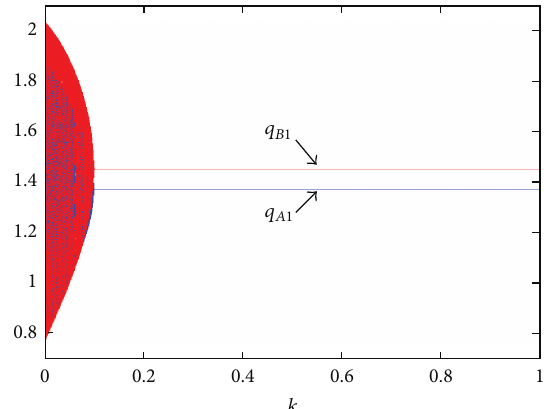
Figure 6: Bifurcation diagrams of system (26) with the controlling factor 𝑘